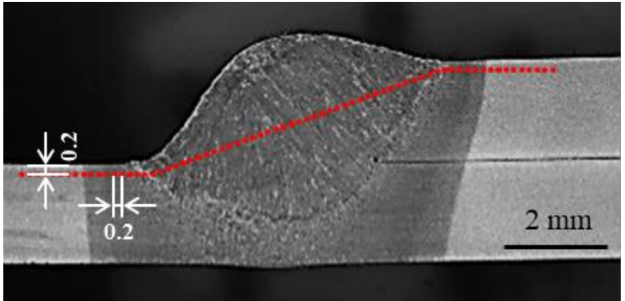
Figure 8. Hardness measurement position of the